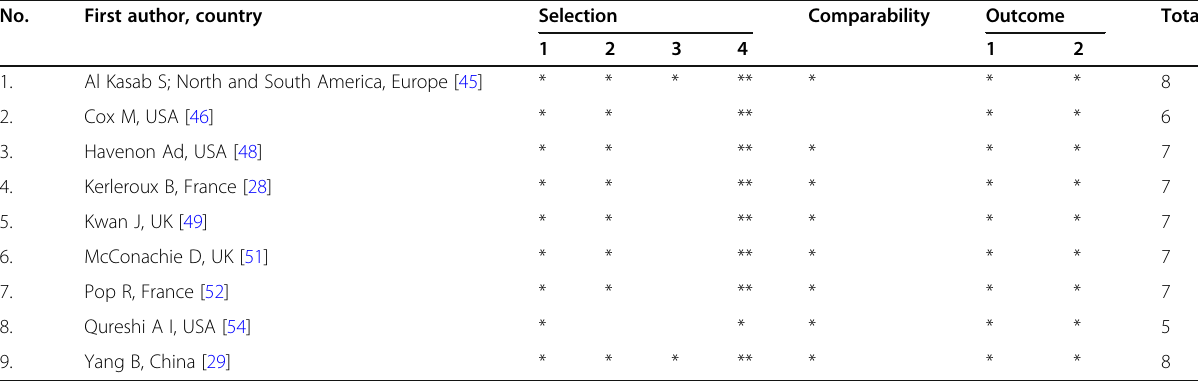
Table 3 Newcastle-Ottawa scale adapted for cross-sectional study No.